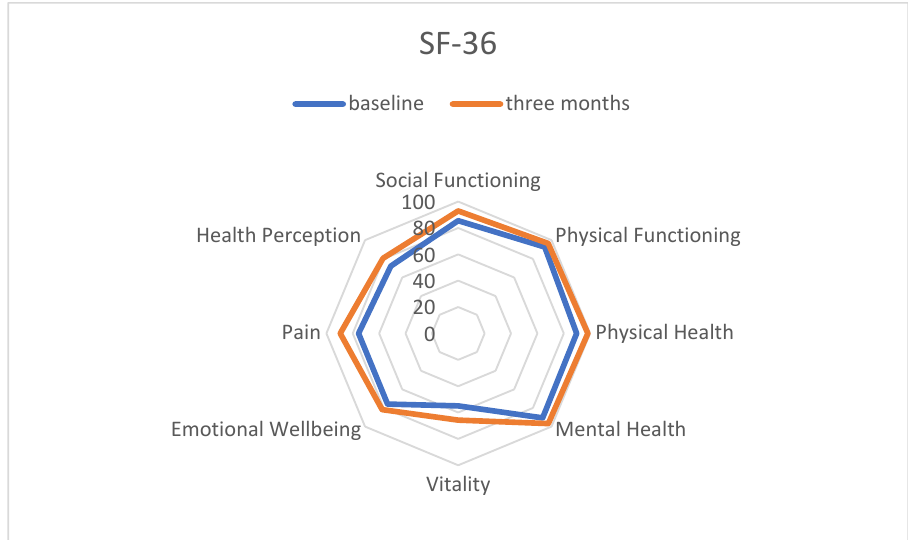
Figure 3. Three-month changes in Quality of Life through intermittent fasting assessed by the Short Form-36 questionnaire.